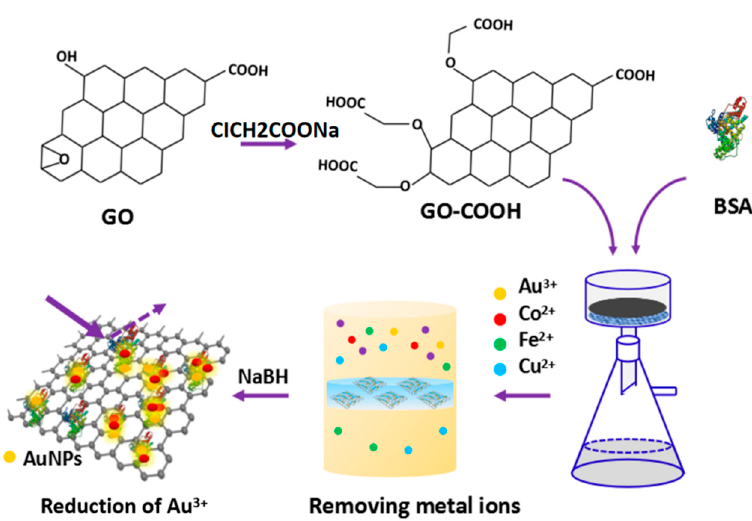
Figure 1. Schematic illustration of the fabrication of graphene oxide (GO)–bovines serum albumin (BSA) hybrid membrane for absorbing metal ions and reduction of metal ions.